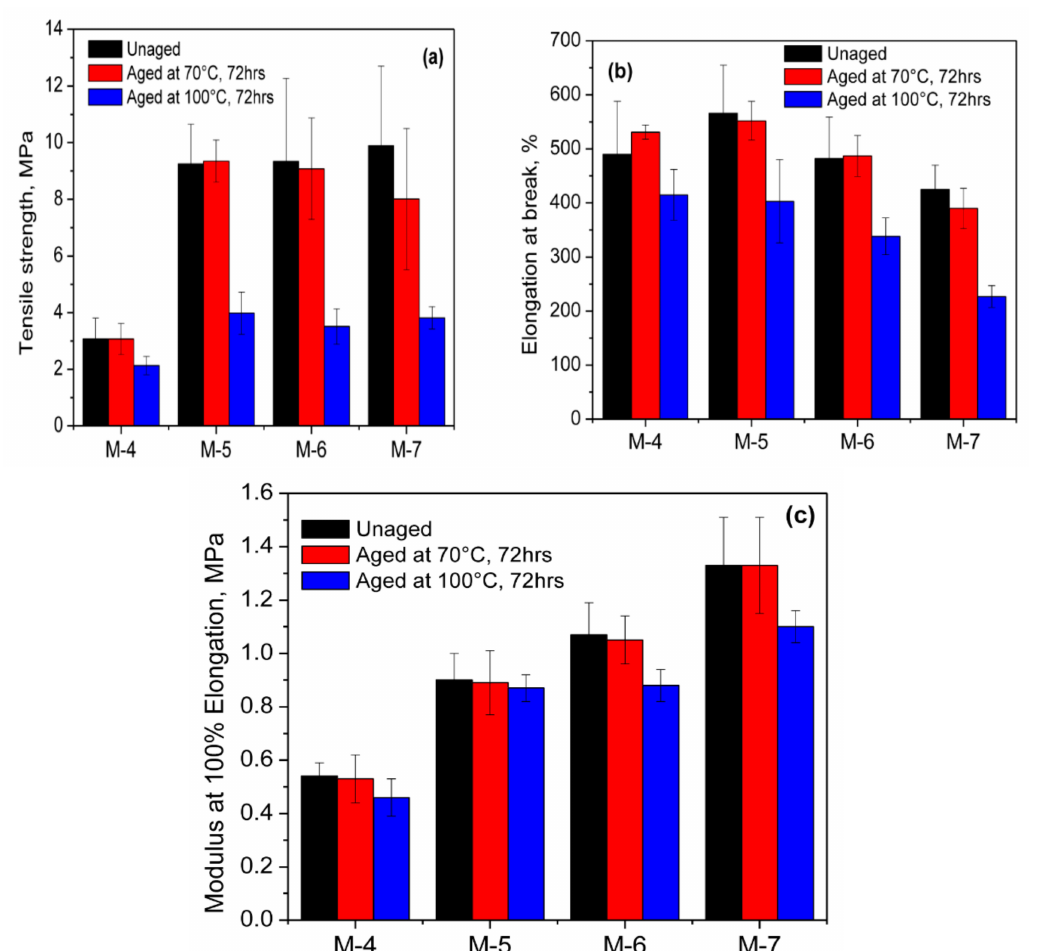
Figure 6. Tensile properties of blend vulcanizates ( a ) tensile strength, ( b ) elongation at break, and ( c ) modulus at 100% elongation before and after